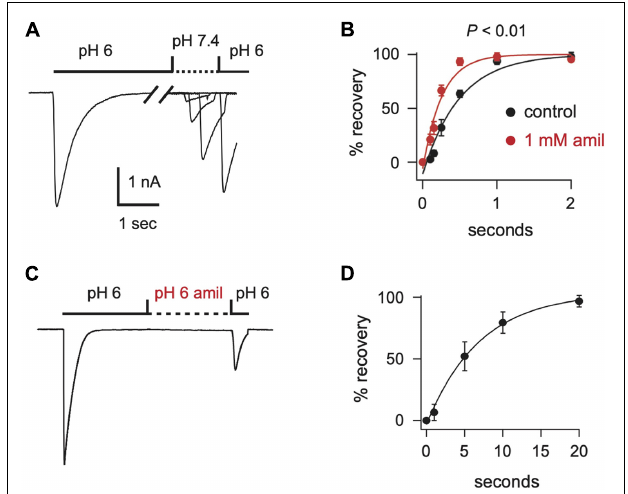
FIGURE 5 | Amiloride increases the rate of recovery from desensitization of ASIC3. (A) Overlay of current traces showing recovery from desensitization. Current was desensitized with a 7 s application of pH 6 (only the first 2.5 s is shown). Cells were then exposed to pH 7.4 solution (containing 0 or 1 mM amiloride) for the indicated times (see x axis in B ) before they were stimulated again with pH 6. Recovery is the percentage of current evoked by the second pH 6 application compared with the first. (B) Mean recovery data as collected with either no amiloride (control) or 1 mM amiloride in the pH 7.4 solution ( n = 3–6 for each point). Lines are fits of single exponentials of the means. Students t -test of the τ ’s calculated from the fits of the individual cells reveals that amiloride increased the rate of recovery ( p < 0.01; n = 6). (C) Current evoked by a 10 s application of pH 6 without amiloride, followed by an exposure to a pH 6 solution containing 1 mM amiloride for variable times (see x axis in D ), followed by a second pH 6 application without amiloride. After a 20 s exposure to the pH 6 solution with amiloride the ratio of the current evoked by the second pH 6 application compared to the first pH 6 application was 0.23 ± 0.04 ( n = 8). (D) Mean normalized recovery data as collected in (C) . Data was normalized to the percentage of recovery at 20 s ( n = 3–6). Line is fit of single exponential of the means ( τ = 6.98